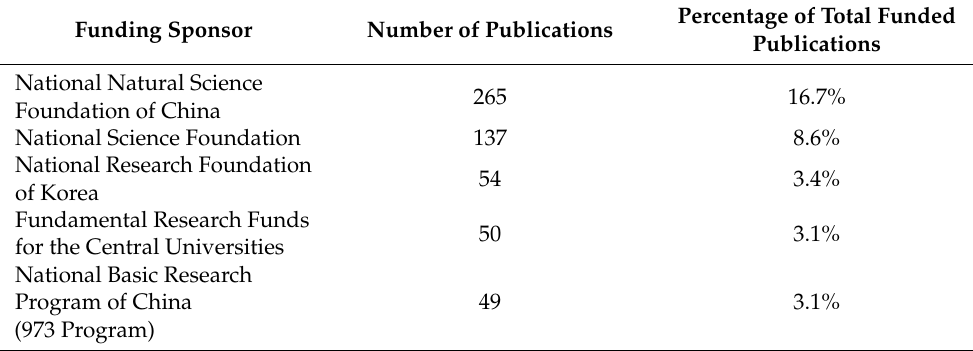
Table 8. Top five funding